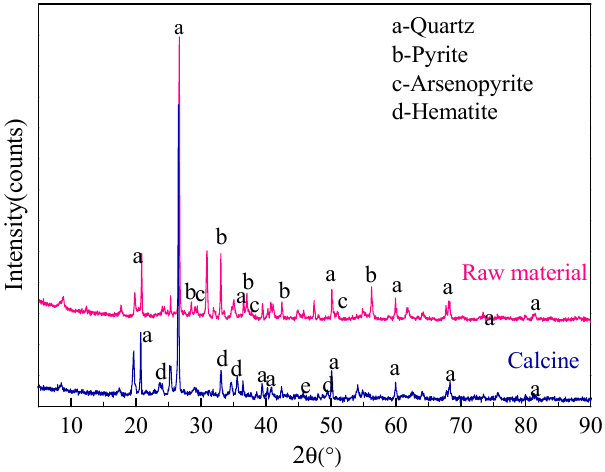
Figure 7. X-ray diffraction pattern of arsenious and sulfur-bearing refractory gold ore and calcine. The surface micro structure and elemental composition of raw ores and hematite in calcine were observed via map analyses with the electron probe microanalysis technique (EPMA). The electron probe microanalysis of hematite in calcine is shown in Figure 8 and Figure 9. It can be seen from Figure 8 and Figure 9 that the pyrite contains some arsenic in raw ore. The gold in ore is extremely fine, and exists as invisible or submicroscopic gold, which does not reveal the presence of any discrete grains of gold. In these gold ores, gold is chemically bound within the arsenopyrite in a non-metallic form, owing to its suitable atomic spacing and crystal chemistry with respect to gold (Swash, 1988). As shown in Figure 8 and Figure 9, comparing with raw ore, most arsenic and sulfur was removed in roasting process, and hematite was the main product of the calcine. The microstructure of hematite is shown in Figure 10. It can be seen from Figure 10 that the hematite possesses a porous structure resulting from the escape of the arsenic or sulphur atoms from the sul- phide grains. Those micro-pores could provide a diffusion channel for CN–, which is conducive to improving the leaching efficiency of gold. Figure 8. The electron probe microanalysis of pyrite ( a ) and hematite in calcine ( b ).